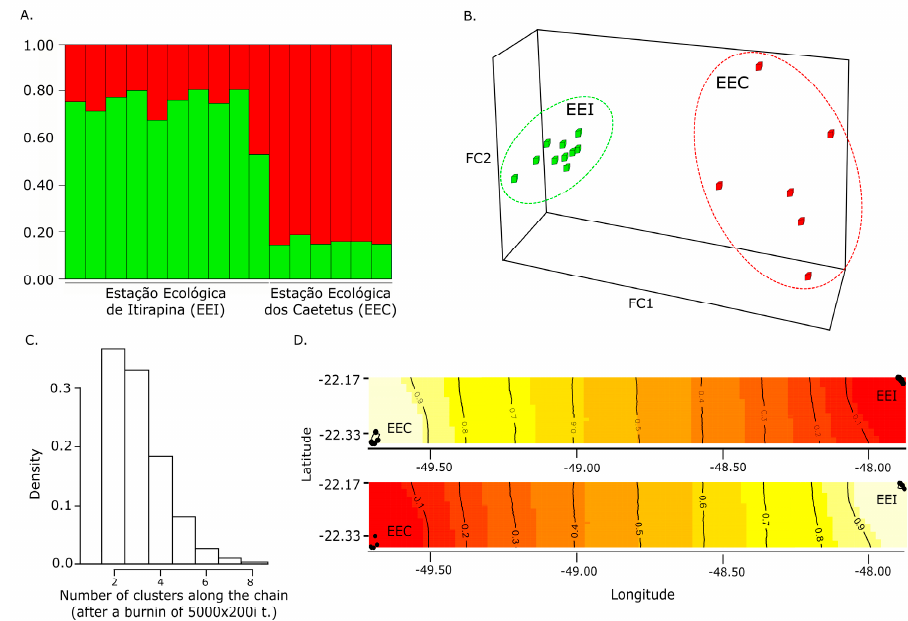
Figure 2. Genetic c lustering analyses: ( A ) Membership coefficient (Q) of each individual in the genetic clusters determined by Structure with K = 2; ( B ) Factorial component analysis graph from Genetix; ( C ) Posterior distribution of the number of clusters estimated in Geneland; ( D ) Maps of the membership posterior probability to the two genetic clusters based on the Geneland analyses. Black dots represent individual samples, contour lines indicate the spatial change in the assignment probability, and lighter colors indicate higher probabilities of membership to a cluster. EEC: Estação Ecológica dos Caetetus; EEI: Estação Ecológica de Itirapina.